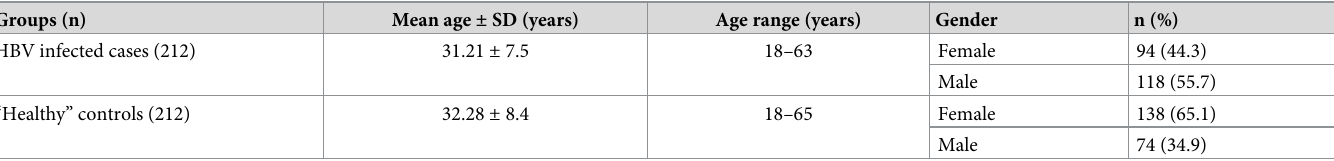
Table 1. Age and gender distribution of participants.